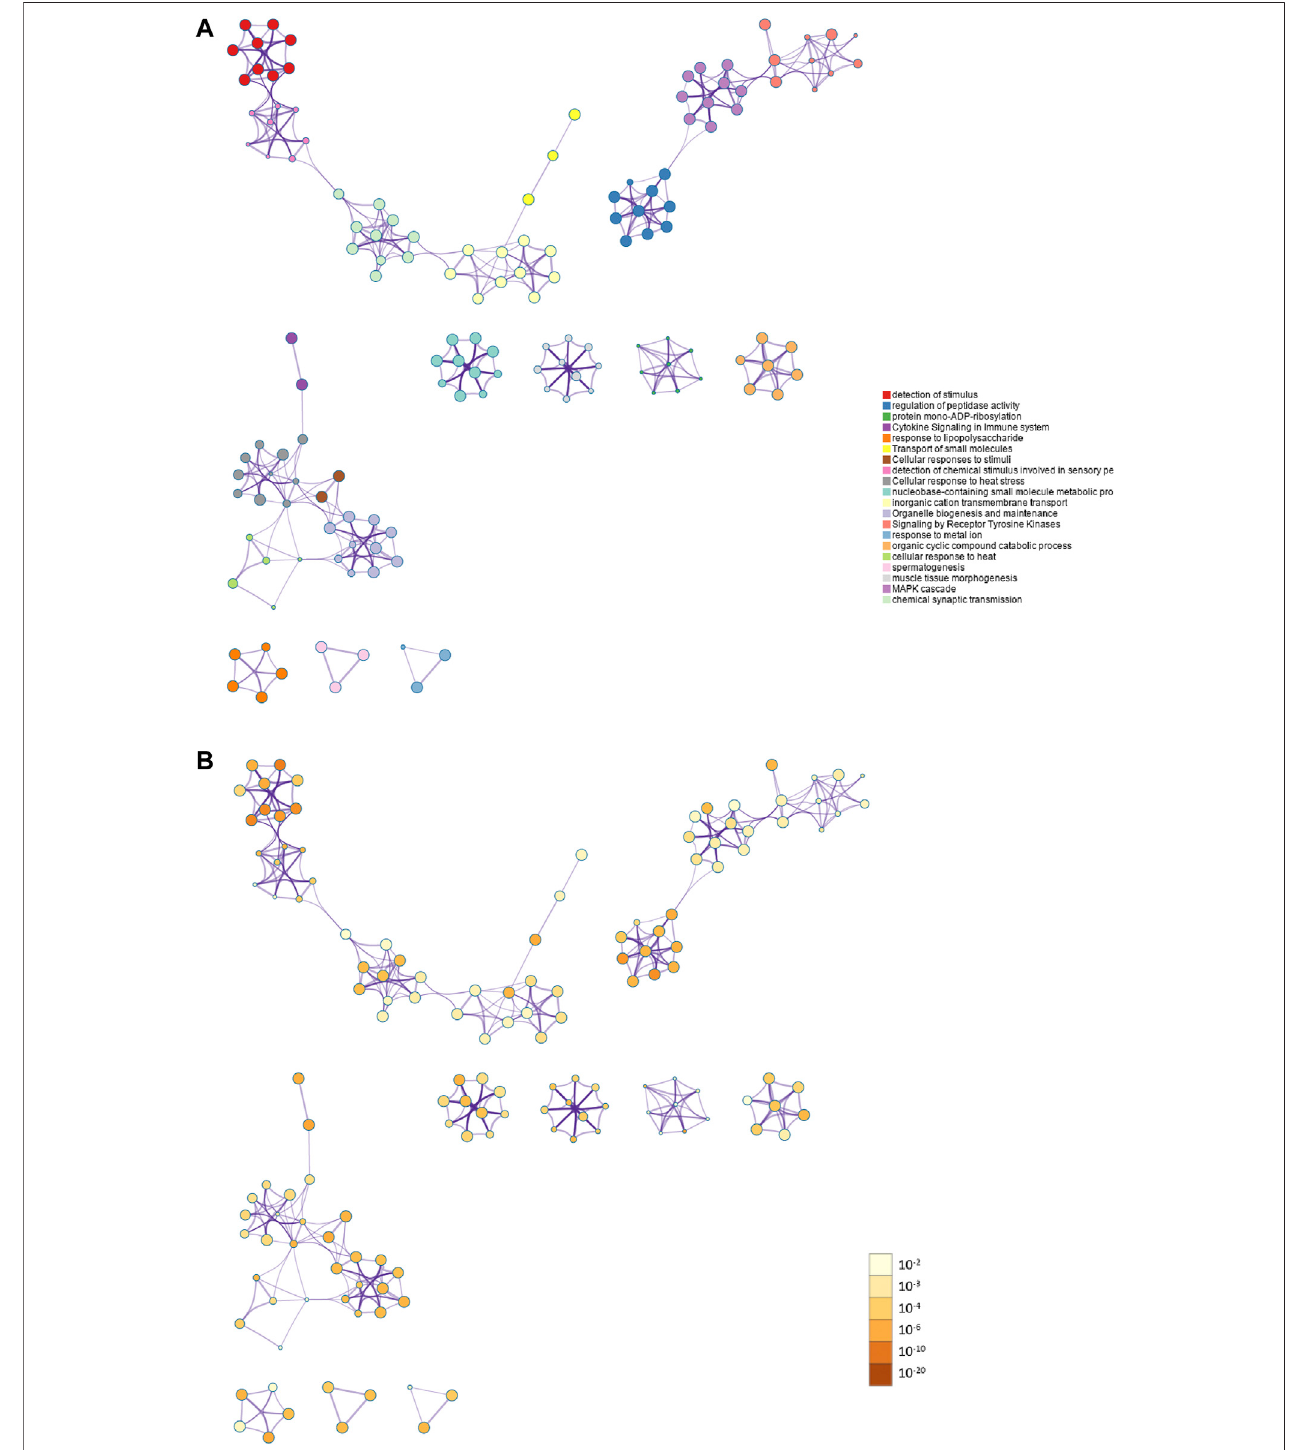
FIGURE 3 | Action view from the PPI network analysis of the candidate genes. (A) The top 20 signi fi cantly enriched biological process and pathways related to ammonia resistance genes with network. Different colors in the map represented different function groups. (B) The same enrichment network had its nodes colored by p -value. The darker the color, the more statistically signi fi cant the node was.